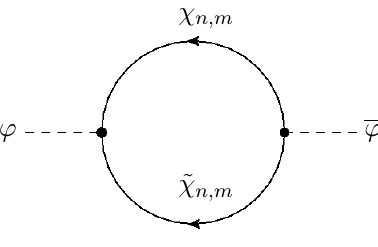
Figure 2. Fermionic contribution to the Wilson line mass without